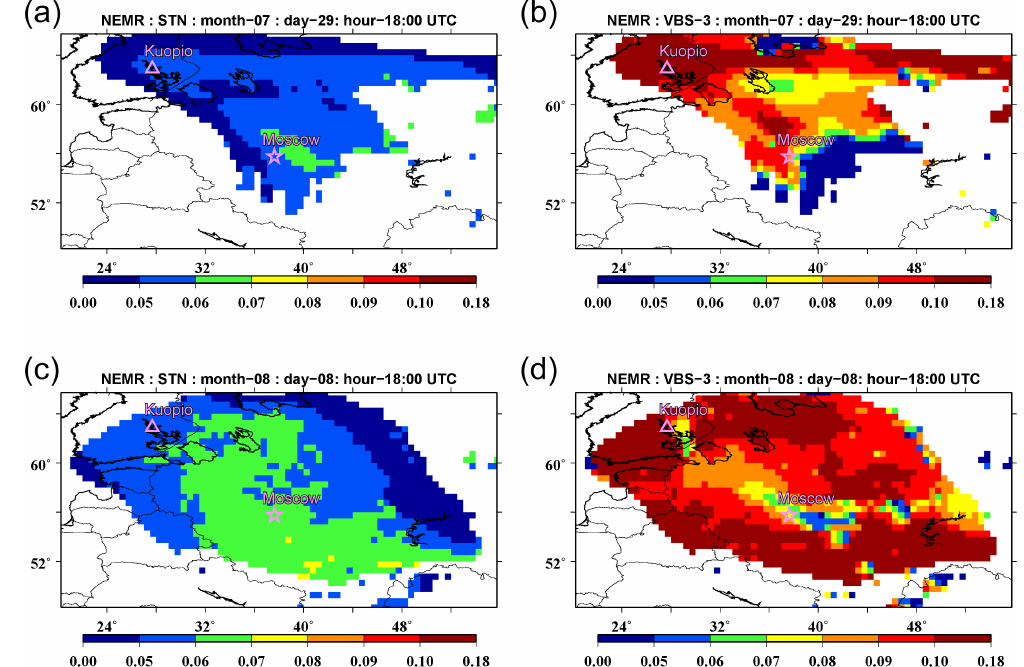
Figure 6. Normalized excess mixing ratio (NEMR) calculated as the ratio of near-surface mass concentrations of PM 10 and CO (gg − 1 ) originating from the fires. The NEMR values are shown only in the grid cells with CO concentrations exceeding 100µgm − 3 for 29 July (a, b) and 8 August (c, d) 2010 according to the STN (a, c) and VBS-3 (b, d) scenarios.